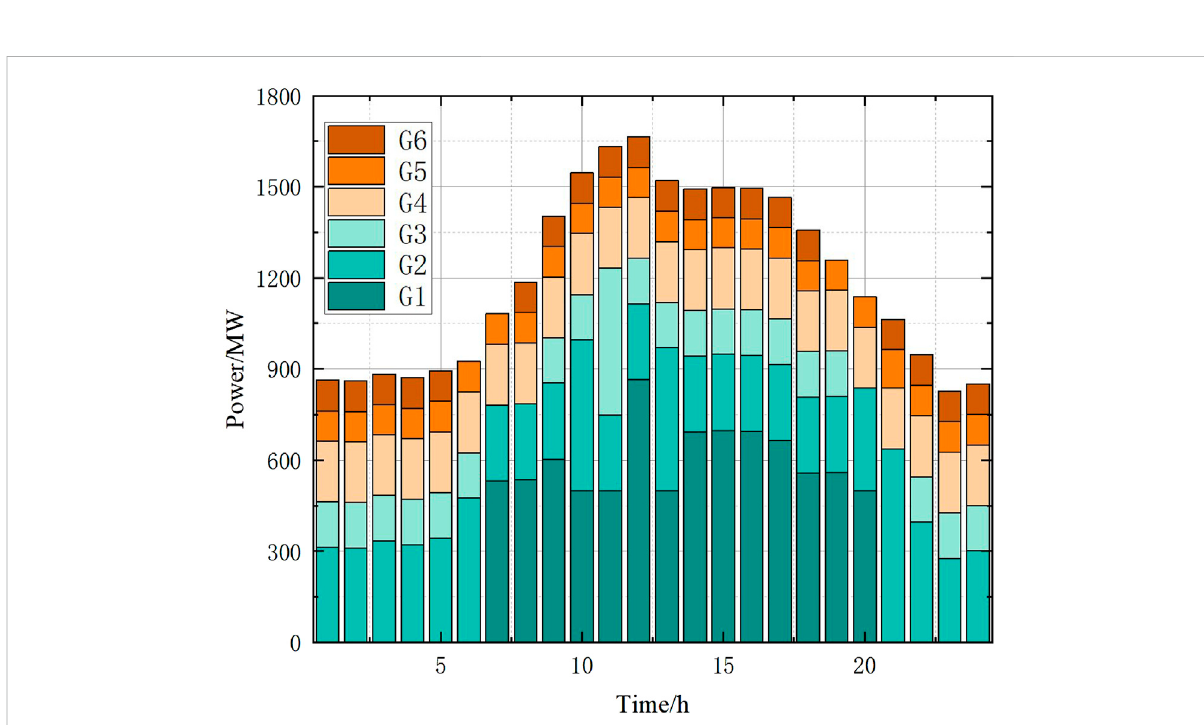
FIGURE 11 Optimal output of thermal power unit after reasonable wind